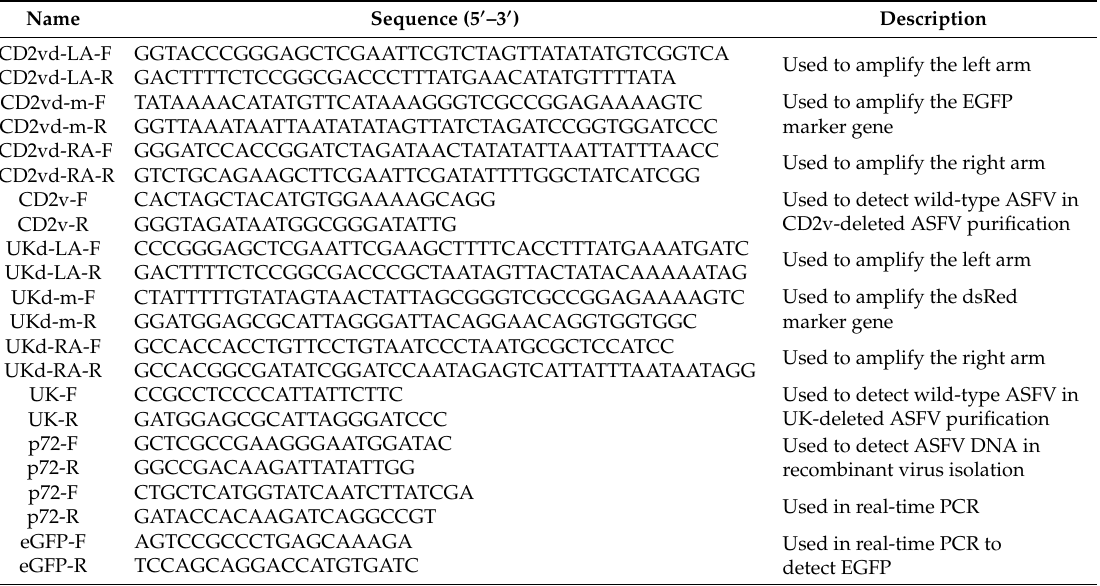
Table 1. Primers used in the